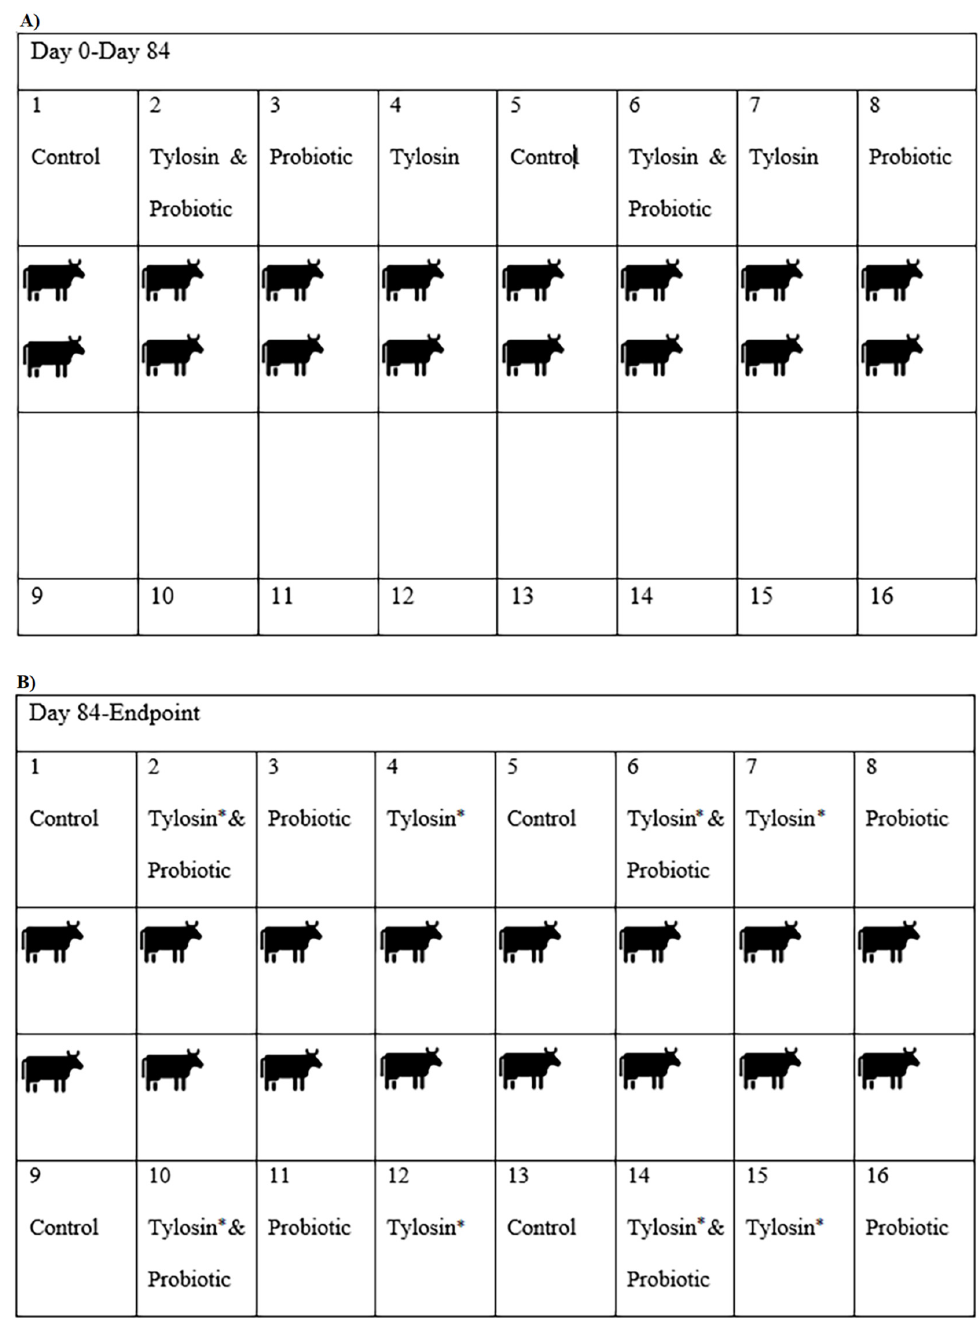
Figure 1. ( A ) Pen layout for first 12 weeks. Each cartoon figure represents six cattle. ( B ) Pen layout Figure 1 A) Pen layout for first 12 weeks. Each cartoon figure represents six cattle. B) Pen layout for for last 4 weeks. Pens 1–8 were the ‘old’ pens, Pens 9–16 were the purpose-built ‘new’ pens. * Cattle were not fed tylosin from this point last 4 weeks. Pens 1-8 were the ‘old’ pens, Pens 9-16 were the purpose-built ‘new’ pens. *Cattle were not fed tylosin from this point forward The first replicate consisted of 90 steers, while the second replicate consisted of 96 166 steers, all sourced from the same ranch birth cohort. Once every 28 days, in the morning, 167 fecal samples were collected per rectum using new individual rectal palpation sleeves for 168 3 months (i.e., from Day 0 to Day 84) by the McGregor, Texas feedlot crew. Following Day